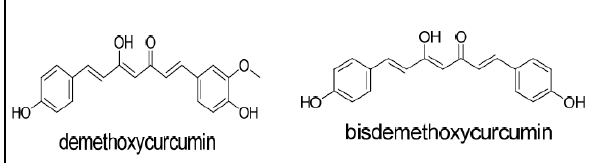
Figure 2: Structure of the minor